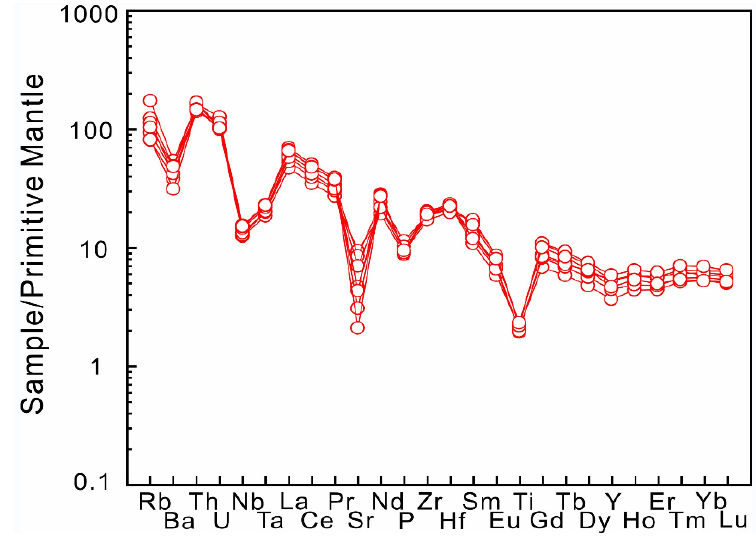
Figure 8. Primitive-mantle-normalized trace element diagram of the Kangjiali gneissic granite. Primitive mantle data are from Sun and McDonough (1989) [26].